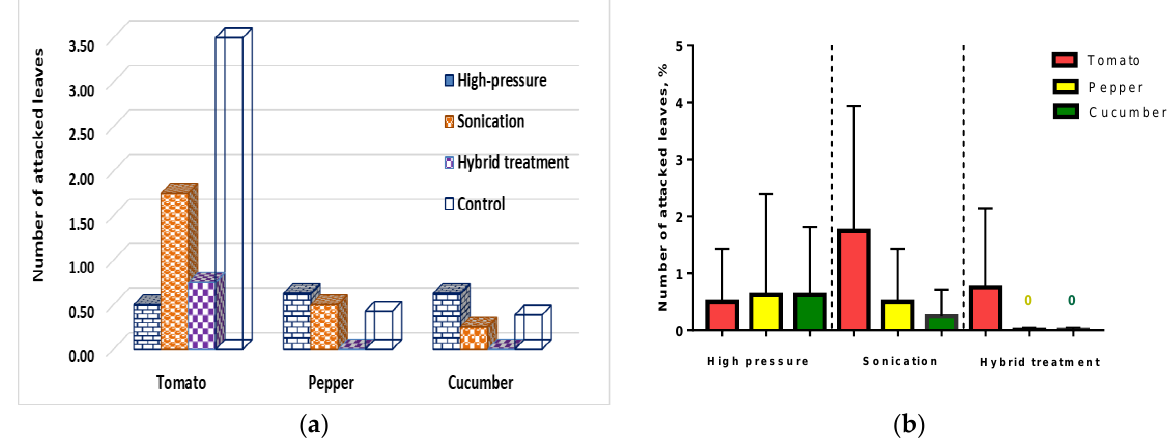
Figure 12. The influence of treatments on pest attack reduction: ( a ) rate of leaves attacked for tomato, pepper, and cucumber crops and ( b ) comparative evaluation of the extracts’ impact on seedlings’ resistance to pests (median and standard deviation statistical processing).